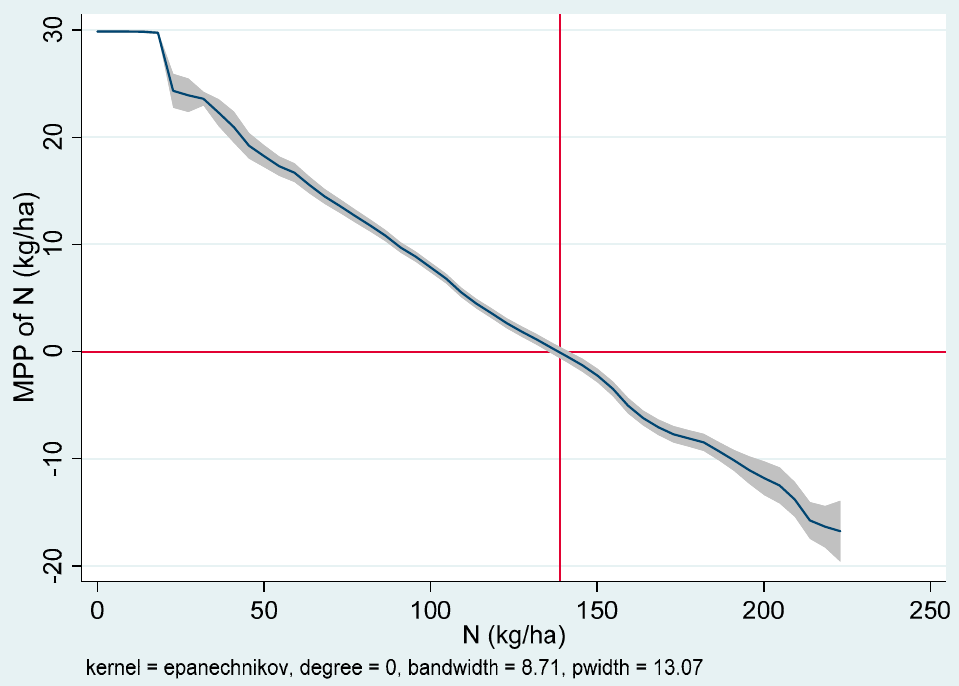
N ) at the mean level in Aduthurai,